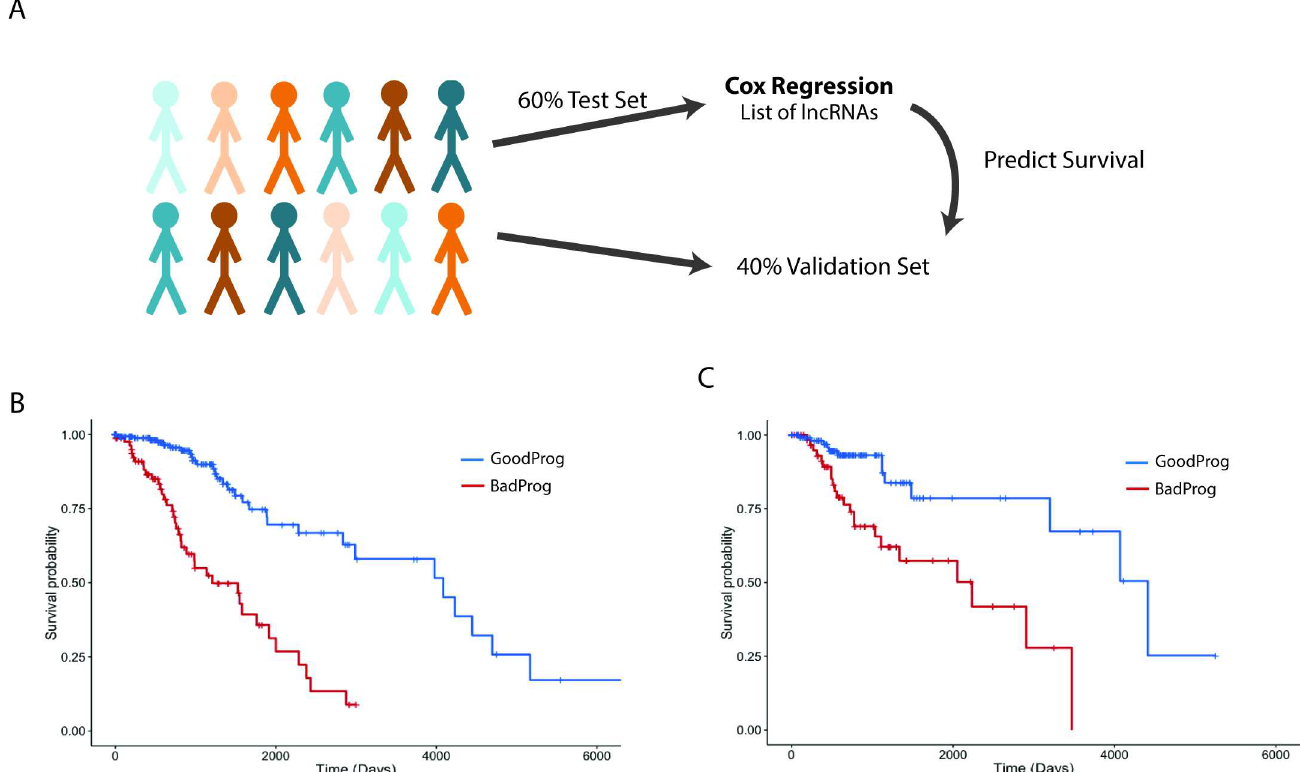
Fig 5. Expression of a subset of lncRNAs is associatedwith survival in LGG patients. (A) Schematic of survival analysis:60% of LGG patients were randomly selectedto be the test set used to find survival-associated lncRNAs using Cox regression analysis. A summed Cox coefficientderived from 64 survival-associated lncRNAs (selectedas in S3 Fig) was used to stratify patients in the test set into two survival groups. This same set of 64 lncRNAs was then used to derive the summed Cox coefficient in the validation set to separate them into two survival groups. (B) Survivalplot shows the effective separationof patients from the test set into two distinct survival groups, good prognosis (GoodProg) and poor prognosis (BadProg), based on each patient’ssummed Cox coefficient of the 64 lncRNAs(hazard ratio [HR] = 2.168, 95% CI = 1.765–2.807, p < 0.001). (C) The summed Cox coefficient for the same 64 lncRNAsis capableof separatingpatients from the validation set into two groupswith very distinct survival probabilities (HR = 1.921, 95% CI = 1.333–2.767, p < 0.001). LGG, lower grade glioma;lncRNA, long noncoding RNA.